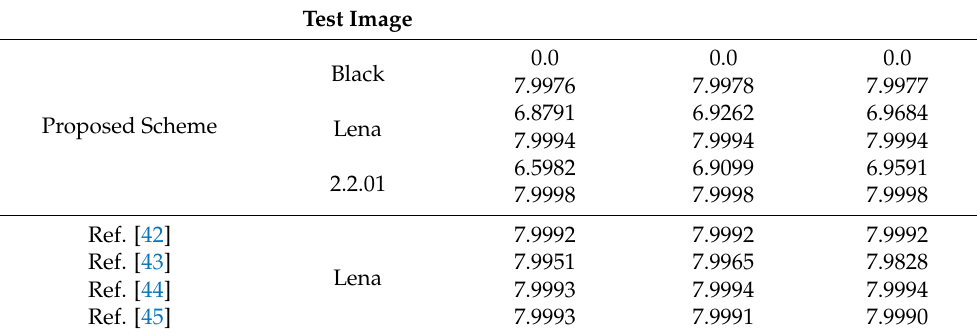
Table 4. Comparison of information entropy of three channels before and after encryption.